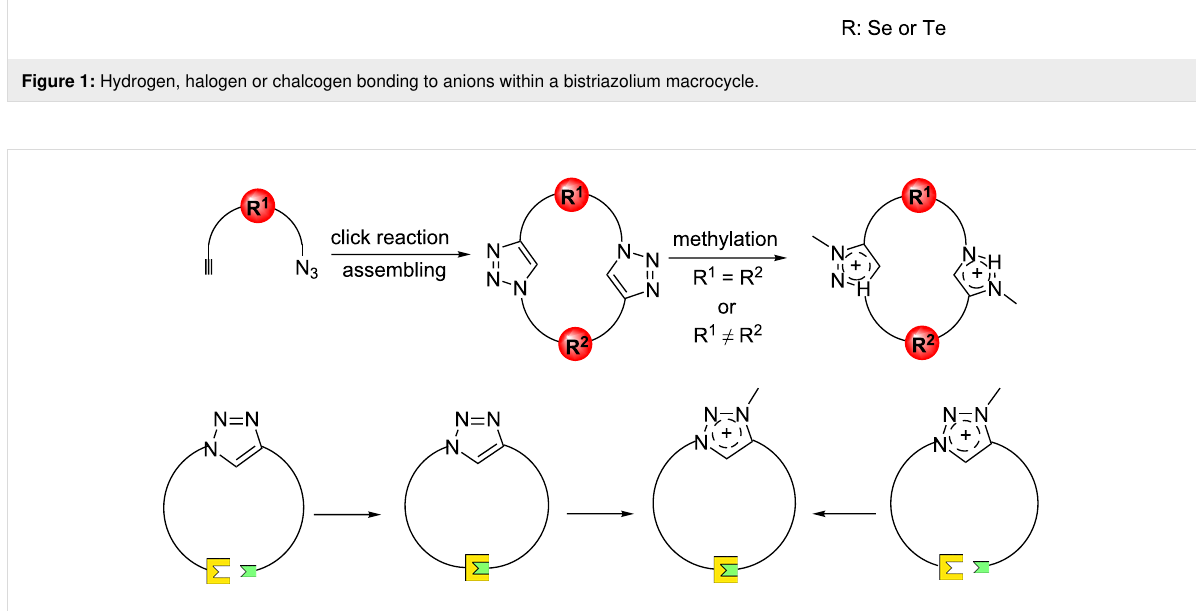
Figure 2: Main synthetic strategies towards macrocyclic